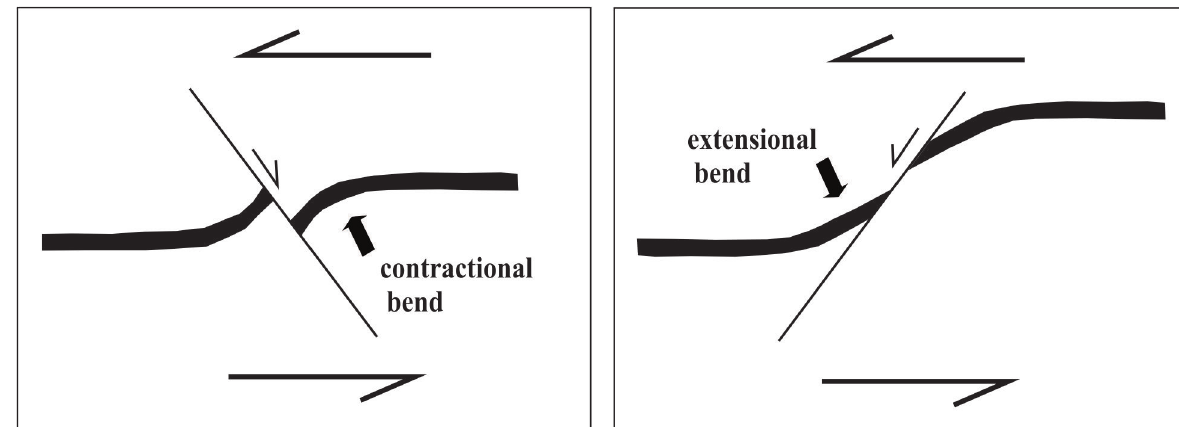
Figure 1 - Sketches of two different types of flanking folds in a shear zone (modified from Grasemann et al.